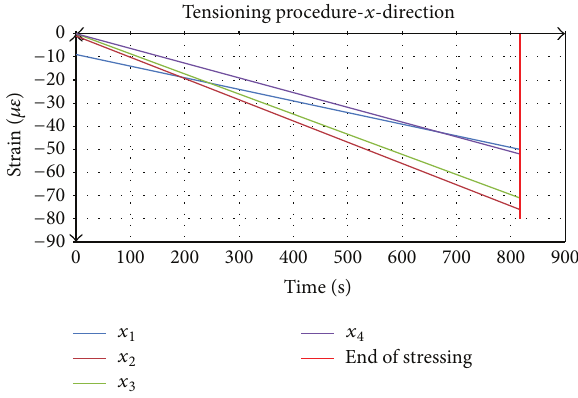
Figure 36: Strains parallel to applied axial compression.